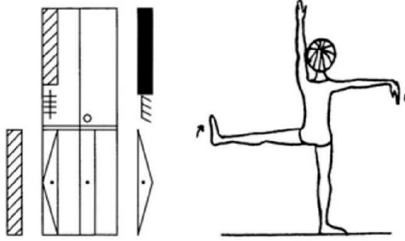
Figure 8. Example of hand and foot actions notated in Kinetography and shown in context. Created by Ann Hutchinson Guest, used with permission from the author.